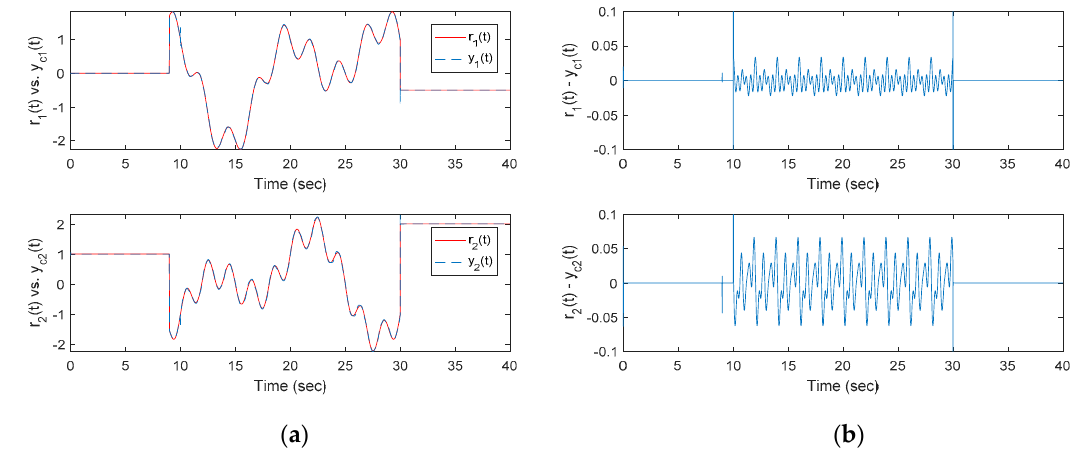
Figure 8. ( a ) Time responses of the closed-loop noisy non-square singular system by the optimal OKID-based LQAT without the EID estimator and ( b ) tracking errors of output e ( t ) = r ( t ) − y c ( t )